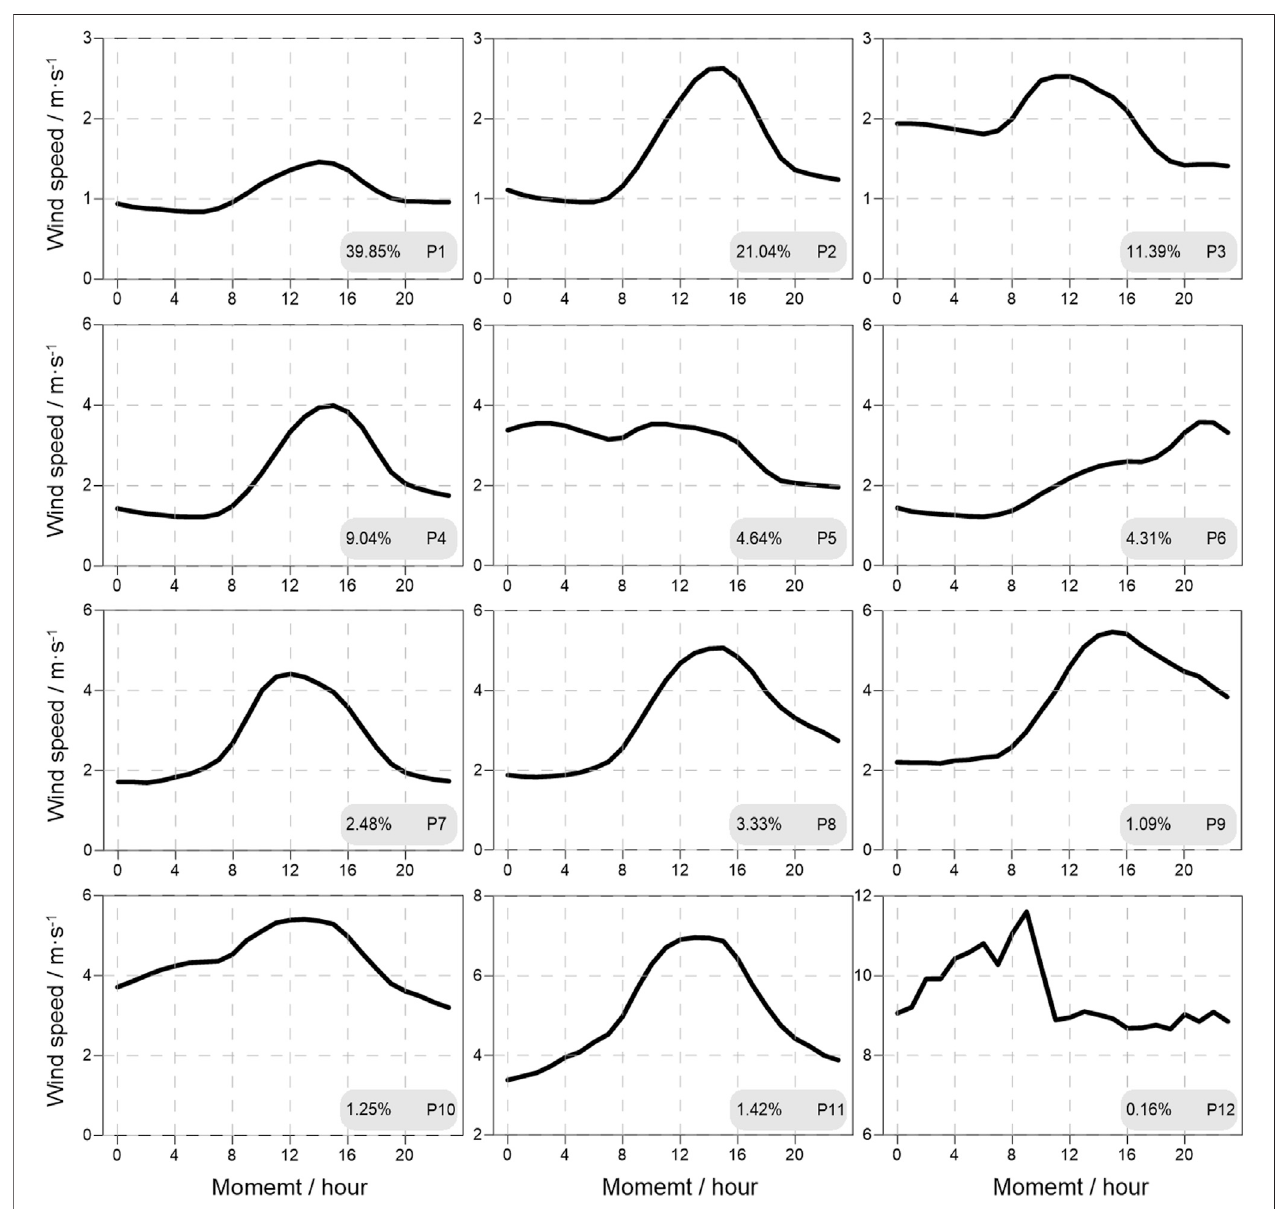
FIGURE 10 | Diurnal variation characteristics of different